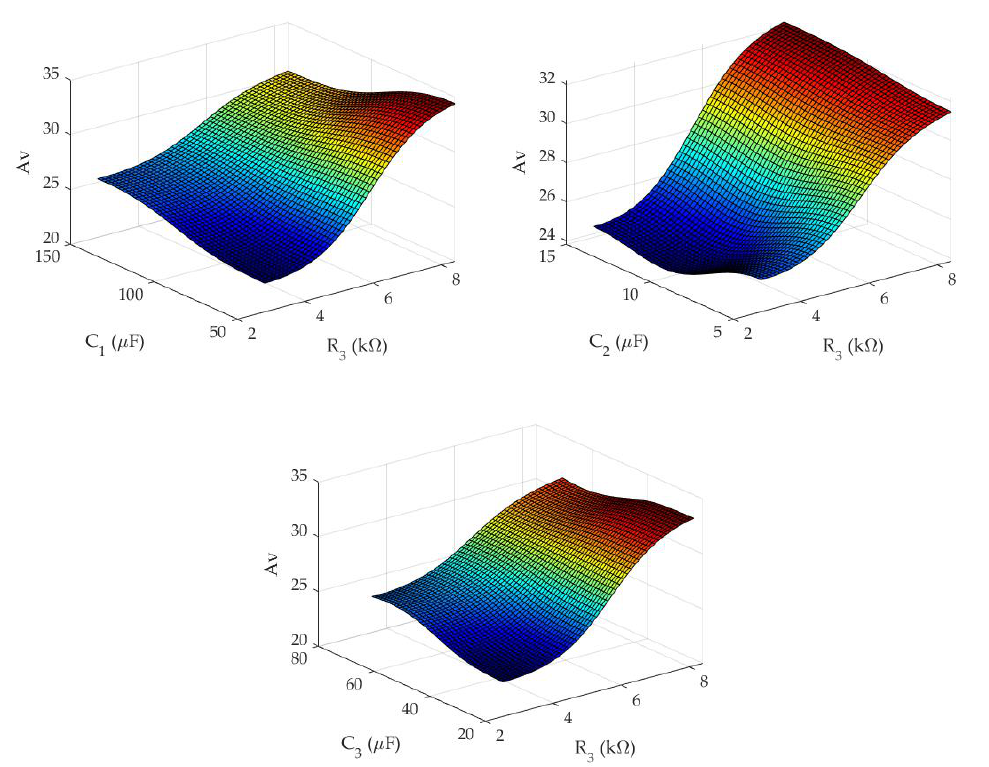
Figure 13. Response surface for Av vs. R 3 and {R 1 , R 2 , R 4 , R 5 , C 1 , C 2 , C 3 }.